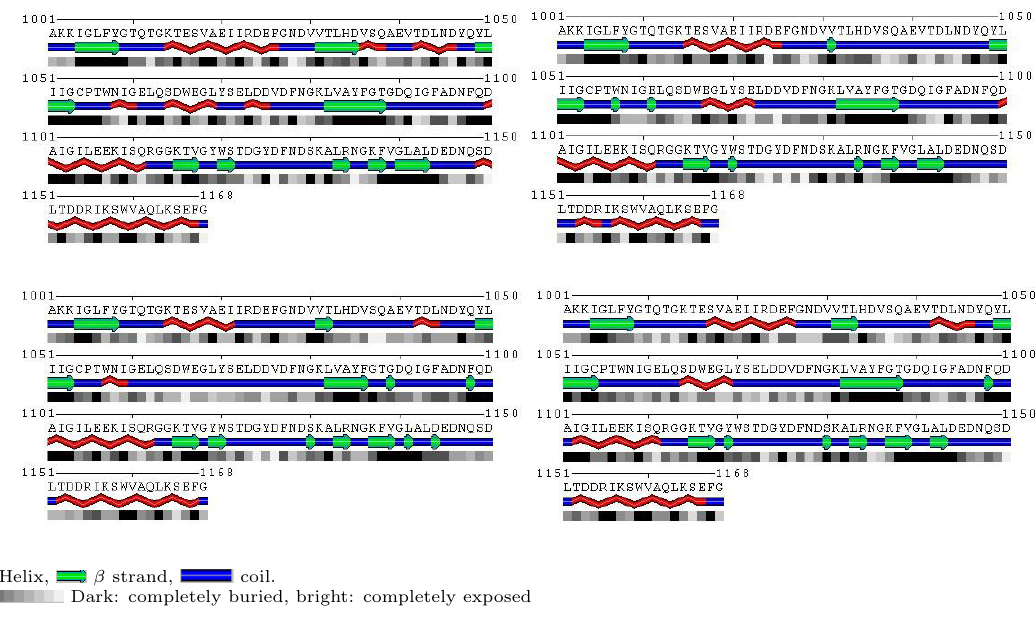
coil. Dark: completely buried, bright: completely exposed Figure 7: The secondary structure of the Flavodoxin, along with the solvent-accessible surface area for its residues in systems A (top-left), B (top-right), C (bottom-left) and D (bottom-right).